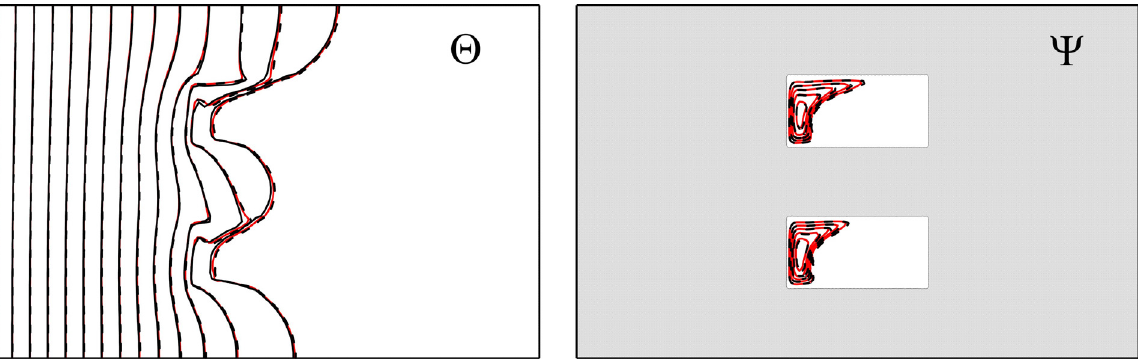
Figure 3. Isotherms Θ and streamlines Ψ for L = 0.02 m and ∆ T = 20 ◦ obtained for different grids: solid black line— 161 × 101 nodes, solid red line—281 × 176 nodes, dashed line—401 × 251